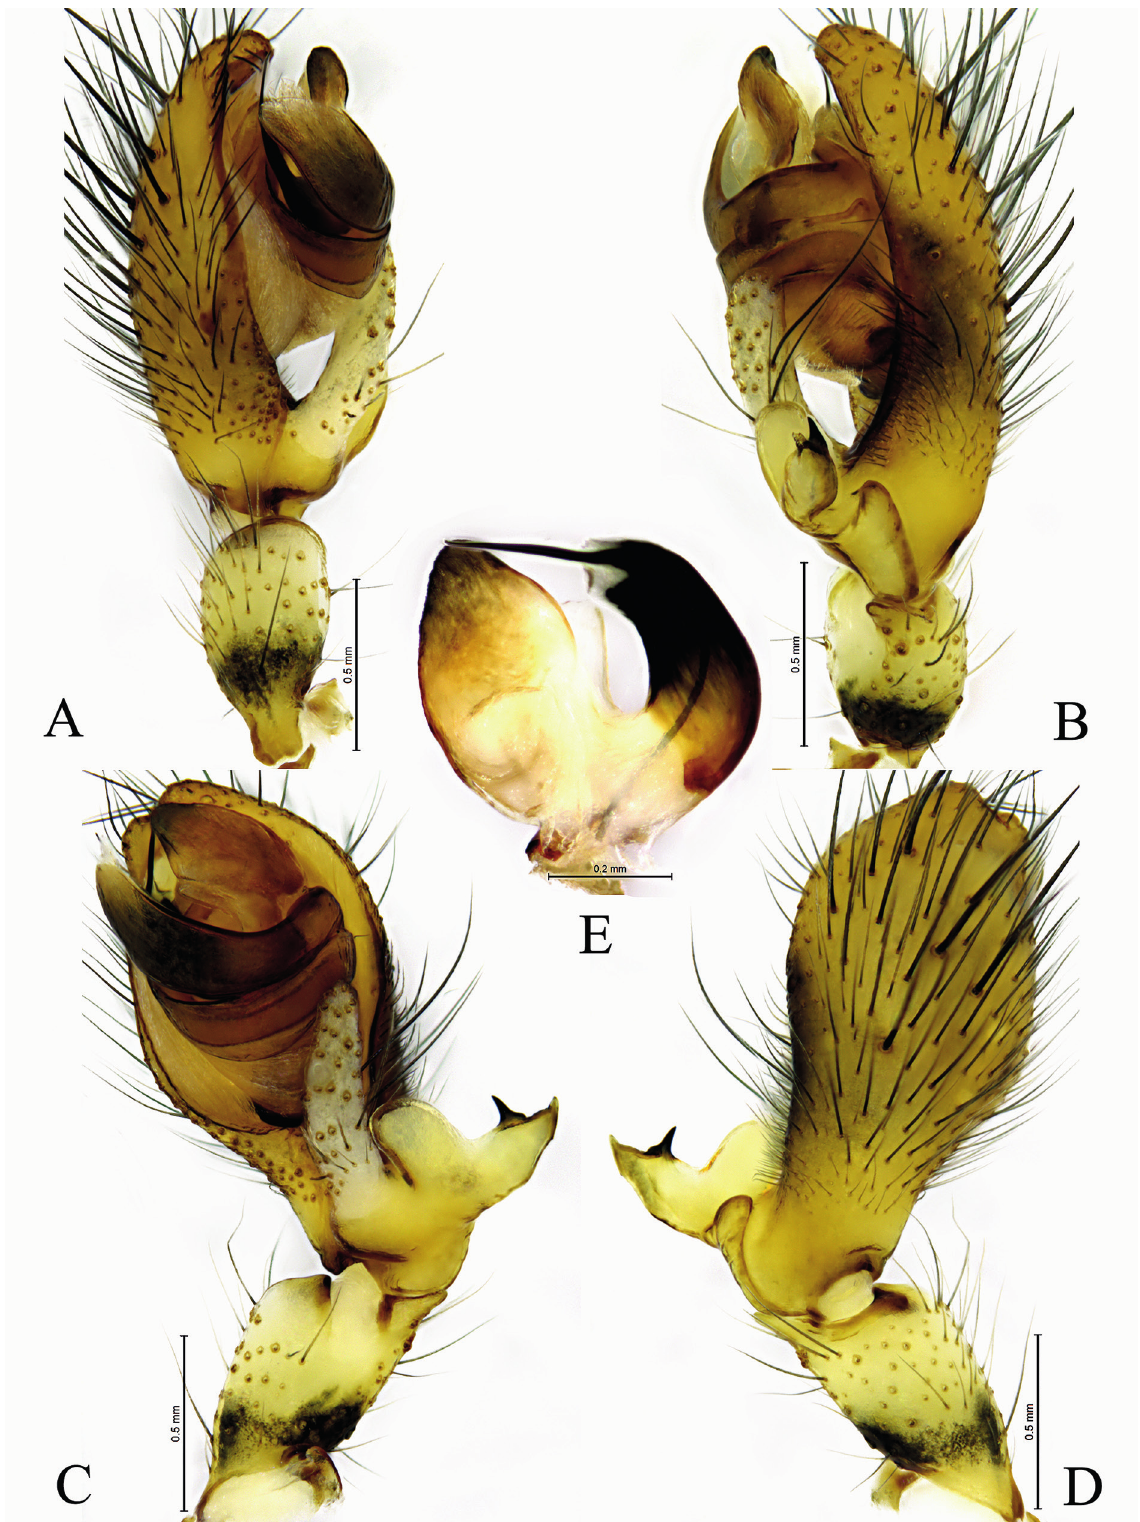
Fig. 14. Meta tibet sp. nov. A–D . ♂, holotype (SWUC-T-TEg-06-01). E . ♂, paratype (SWUC-T- TEg-06-02). A . Left palp, prolateral view. B . Same, ventral view. C . Same, retrolateral view. D . Same, dorsal view. E . Embolus and metaine embolic apophysis, dorsal